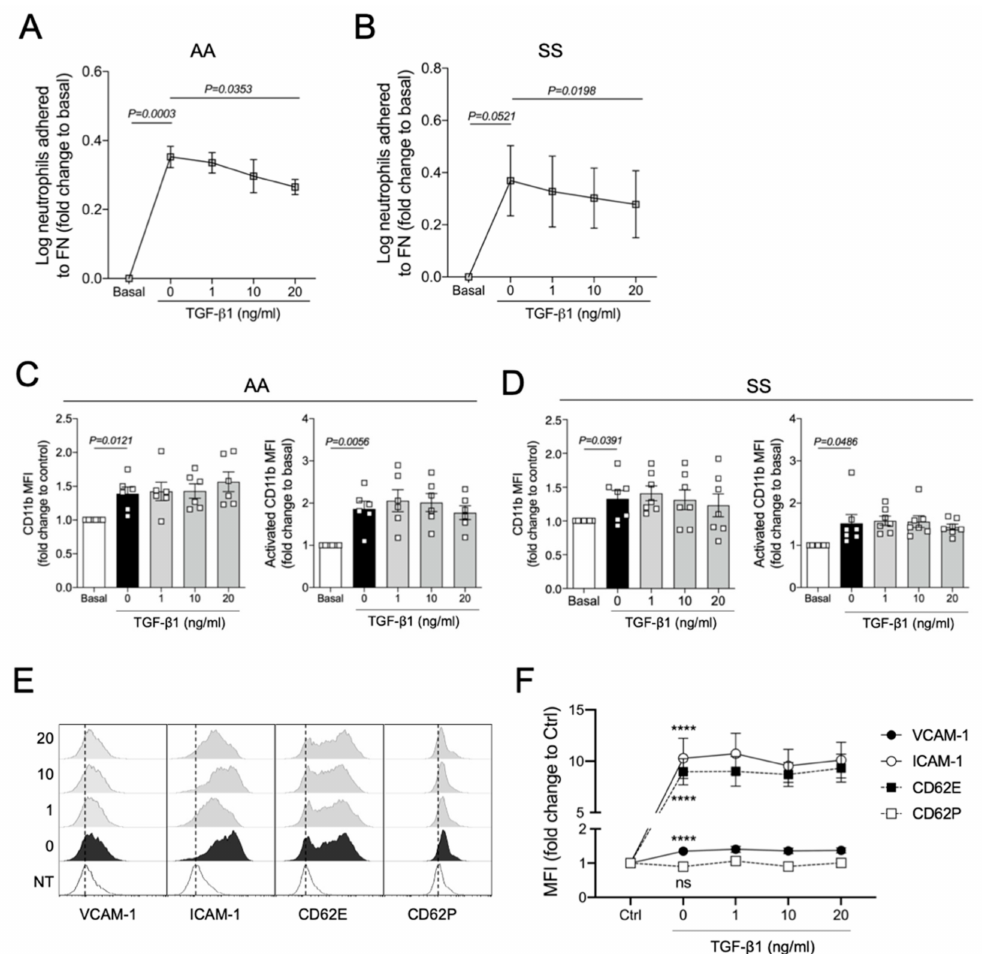
Figure 4. In vitro effects of TGF- β 1 on human neutrophils and immortalized endothelial cells: ( A ) TNF α -induced adhesion of control human neutrophils (AA, N = 5) and ( B ) neutrophils from SCD patients (SS, N = 5) to fibronectin (FN) under different TGF- β 1 treatments; ( C ) TNF α -induced expression and activation of CD11b on neutrophils from controls (AA, N = 6) and ( D ) SCD individuals after treatment with different concentrations of TGF- β 1 (SS, N = 7)’ ( E ) Histograms illustrating